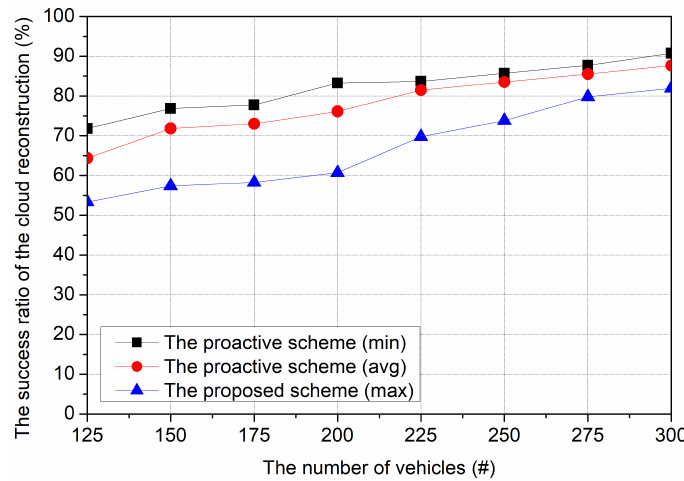
Figure 3. The success ratio of the cloud reconstruction for the number of vehicles.